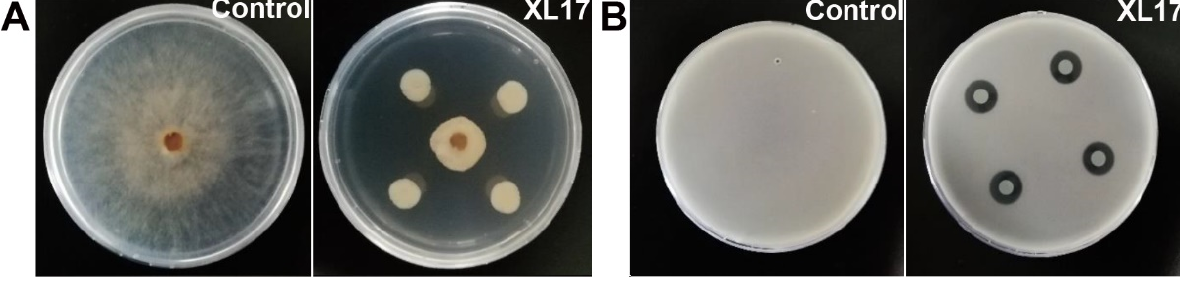
Figure 1. XL17 inhibits growth of gray mold Botrytis cinerea grown on potato dextrose agar for 7 d ( A ) and bacterial canker pathogen Pseudomonas syringae pv. actinidiae grown in LB agar for 3 d ( B ).